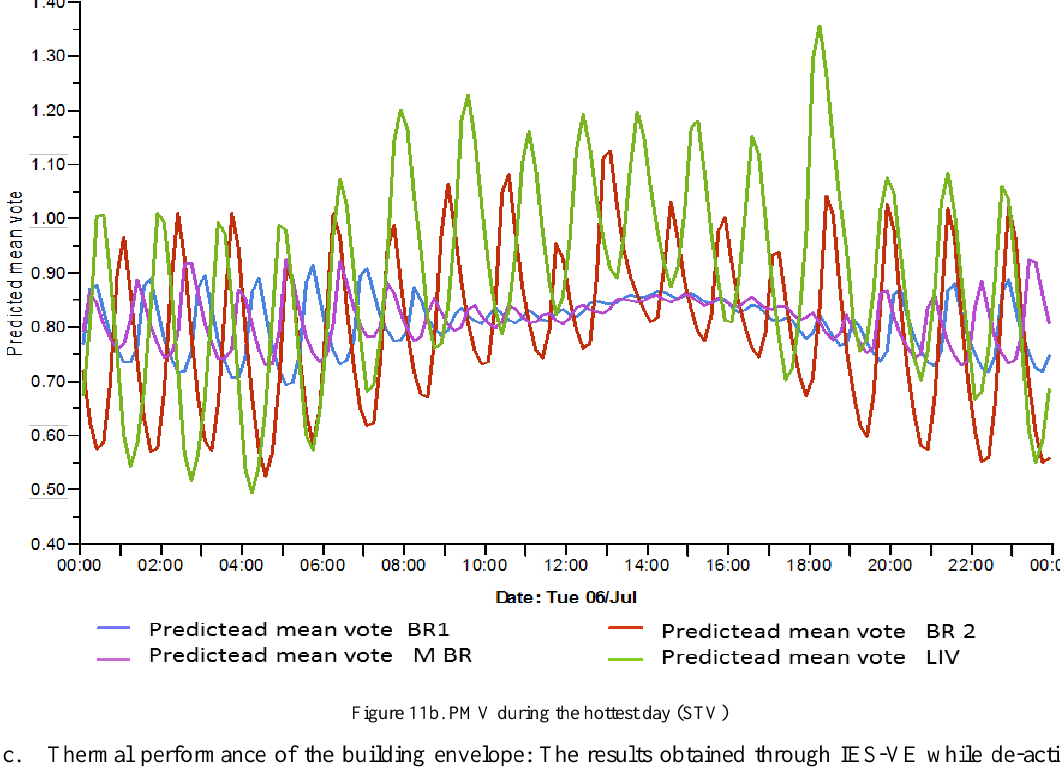
Figure 11b. PMV during the hottest day (STV)